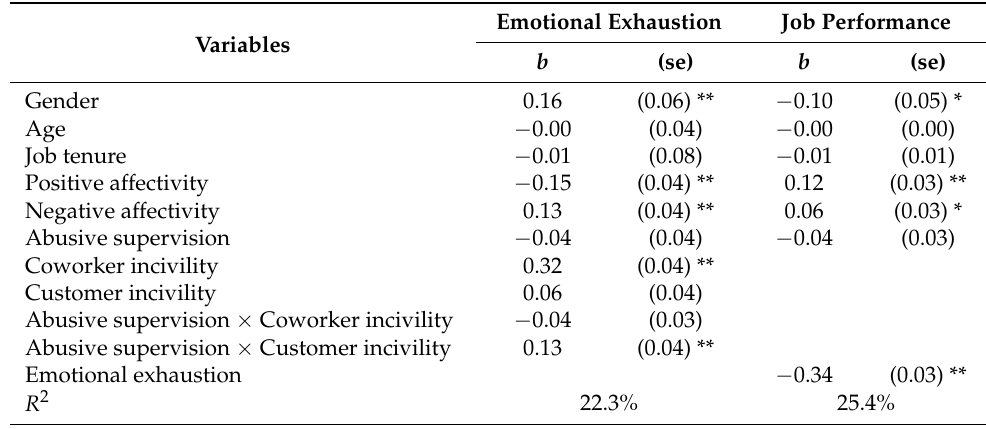
Table 4. Test of the interaction effects of abusive supervision, coworker incivility, and customer incivility.